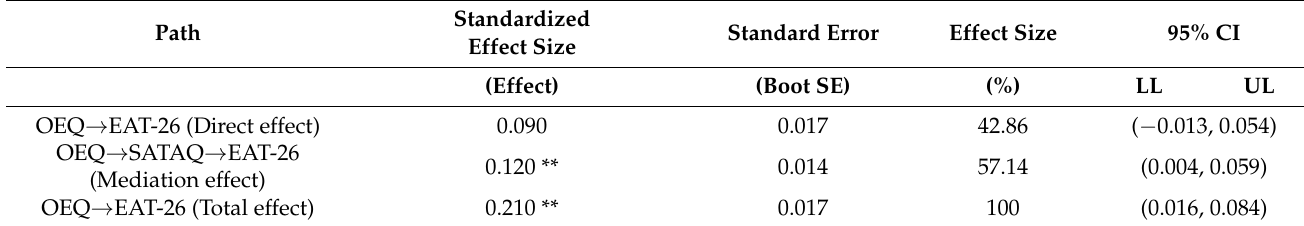
Table 4. Bootstrap analysis of the mediation effect size and significance test of SATAQ in OEQ and